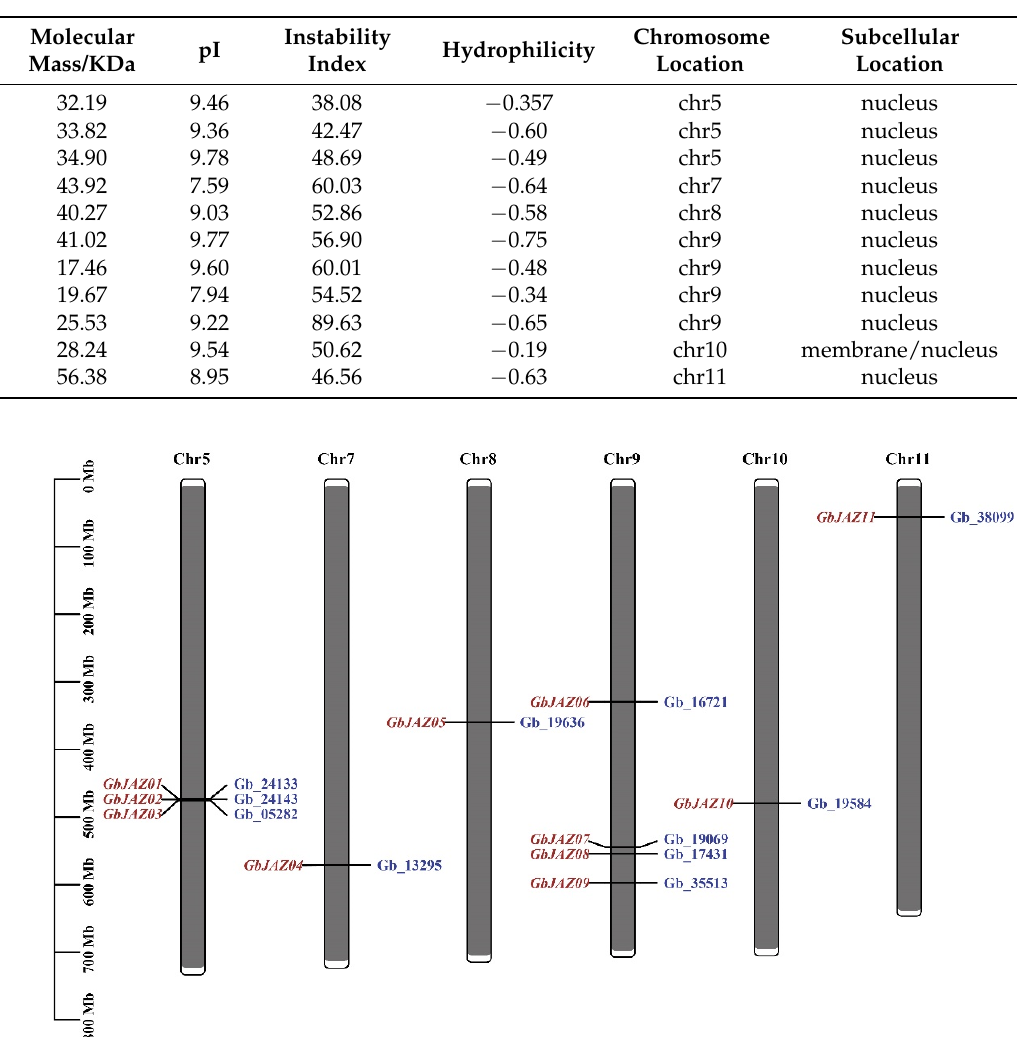
Table 2. Basic information for GbJAZs.